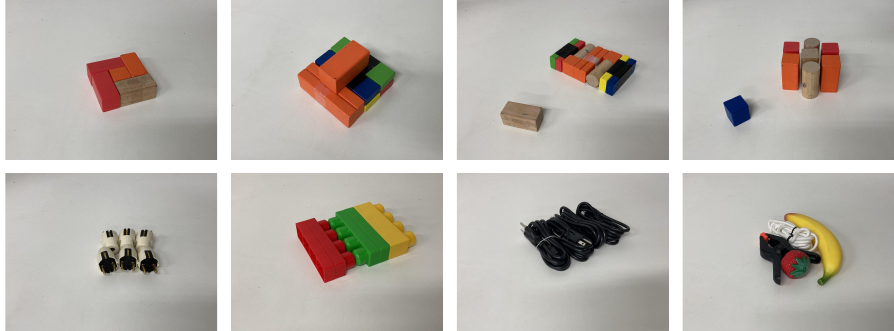
Figure 5. Examples of test scenarios for the real-world setup. Objects are tightly packed, forcing the need for synergy between push-and-grasp primitives. On the first row is a challenging composition made with toy blocks used in training. On the second row is a challenging composition made with novel